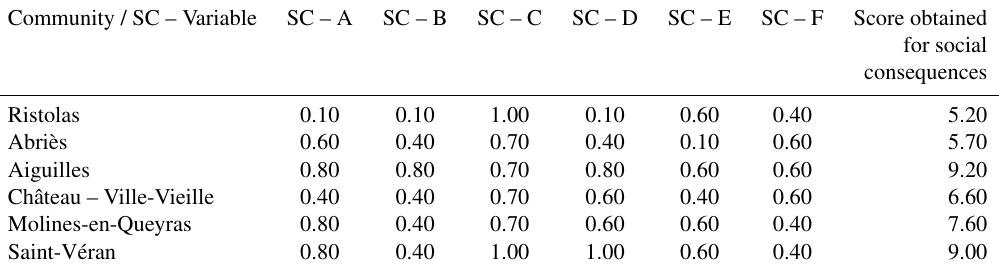
Table 7. SCI scores calculated for the six municipalities of the Upper Guil catchment. Community / SC –